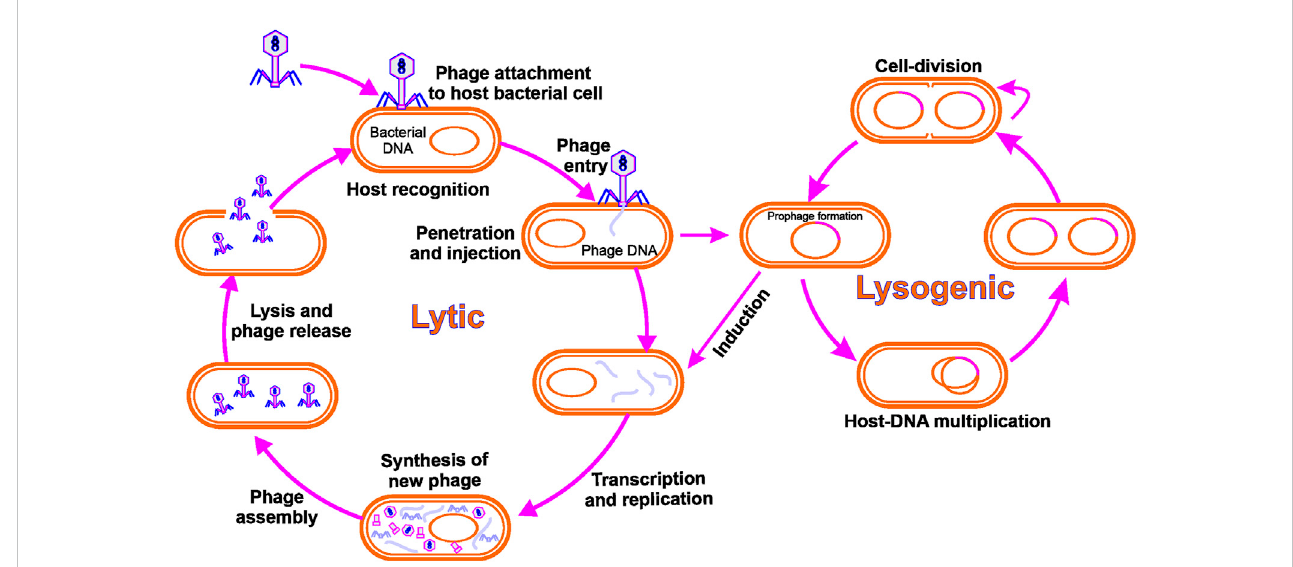
FIGURE 1 Bacteriophagelifecycle:Lyticphagesadheretoandinfectabacterialcell,culminatinginphagereproductionandlysisofthehostcell.Theintegrationof a phage genome into the bacterial genome is the consequence of the lysogenic